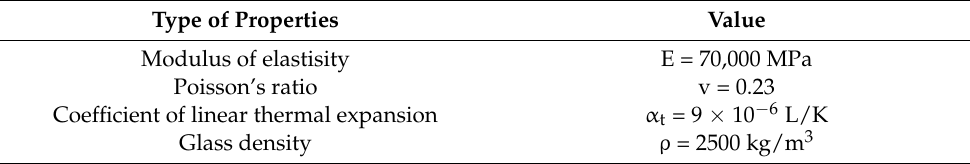
Table 2. General physical and mechanical properties of basic soda lime silicate glass